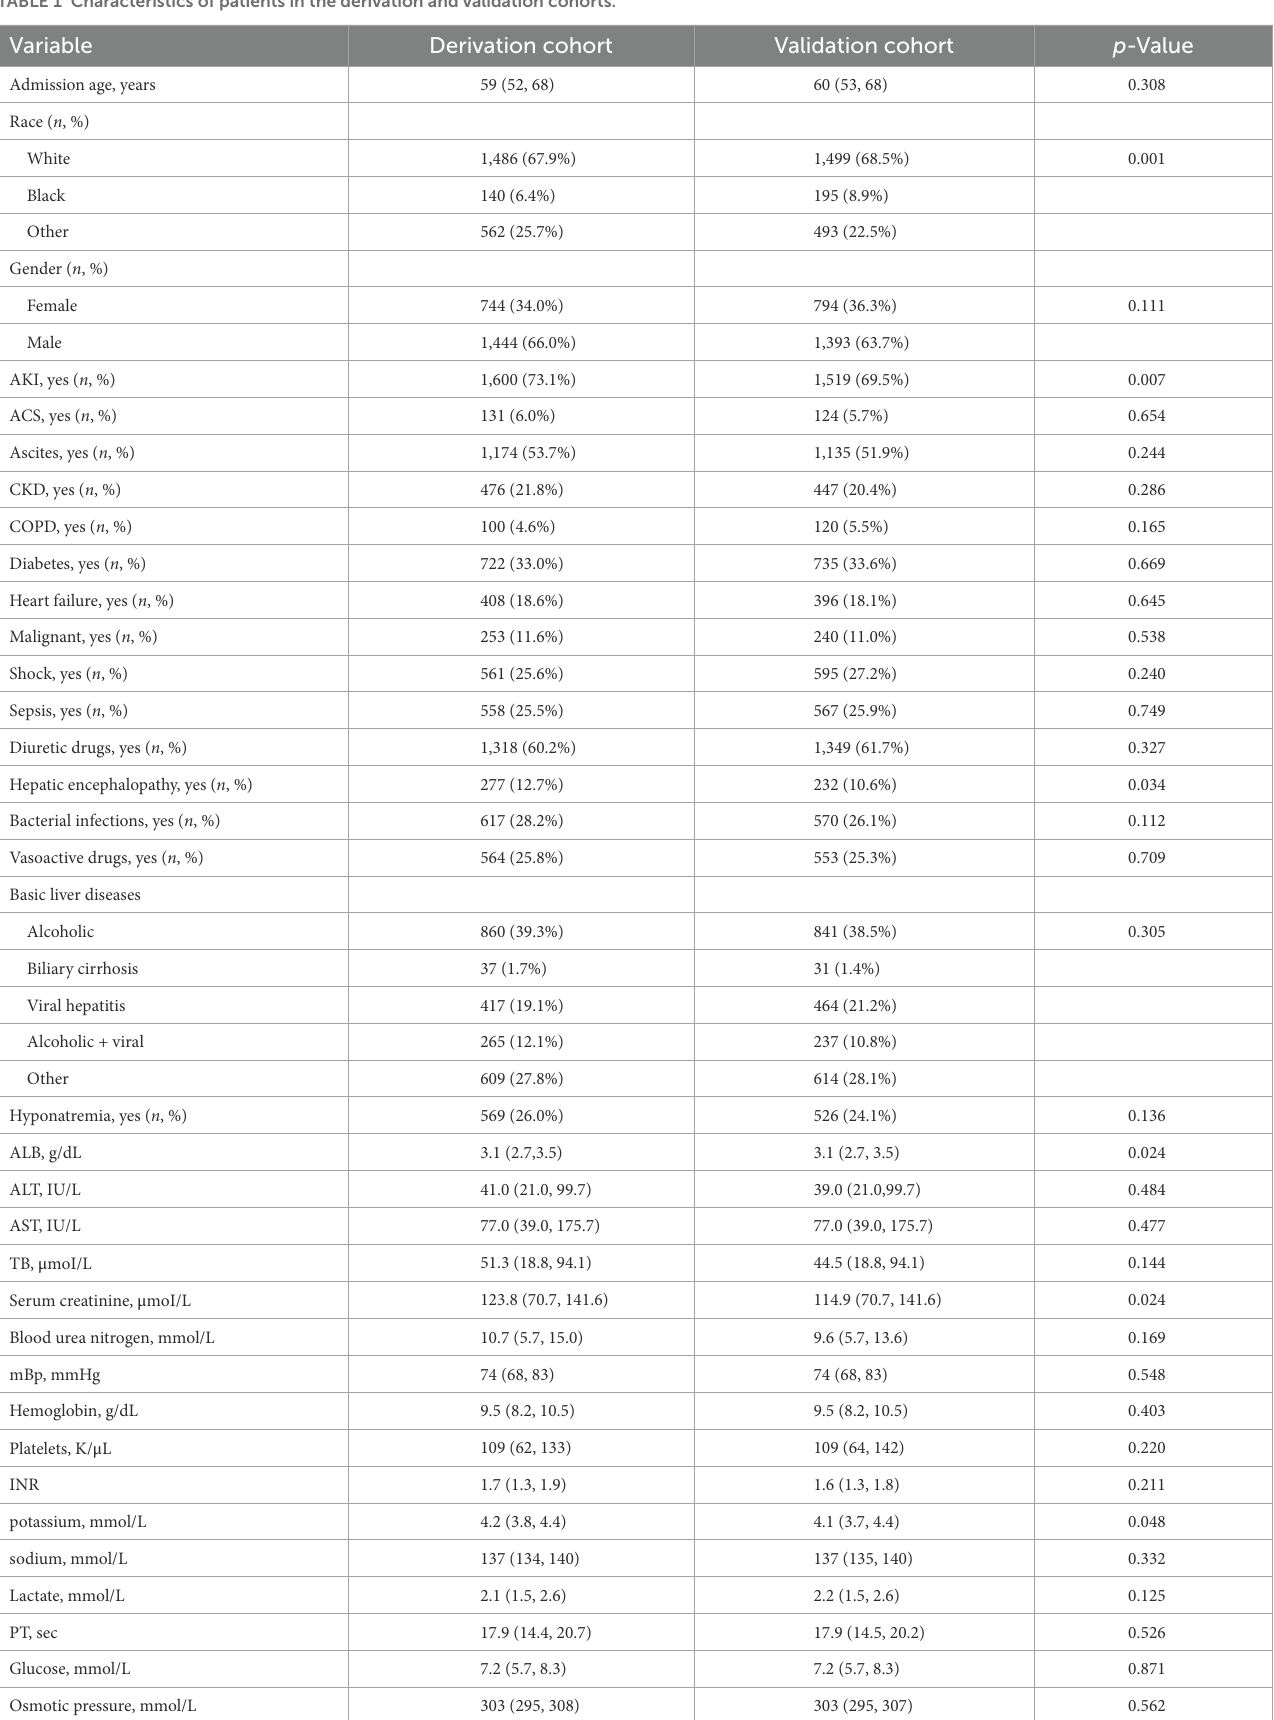
TABLE 1 Characteristics of patients in the derivation and validation cohorts. Variable Derivation cohort Validation cohort p